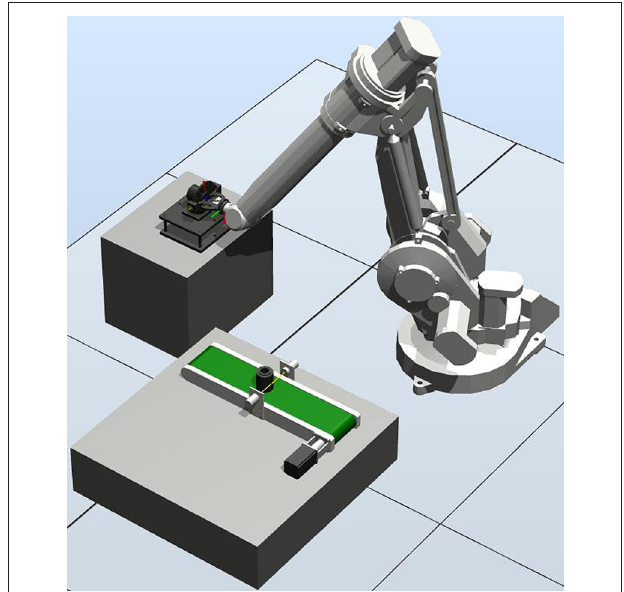
FIGURE 13 | Robot Studio assembly station map.